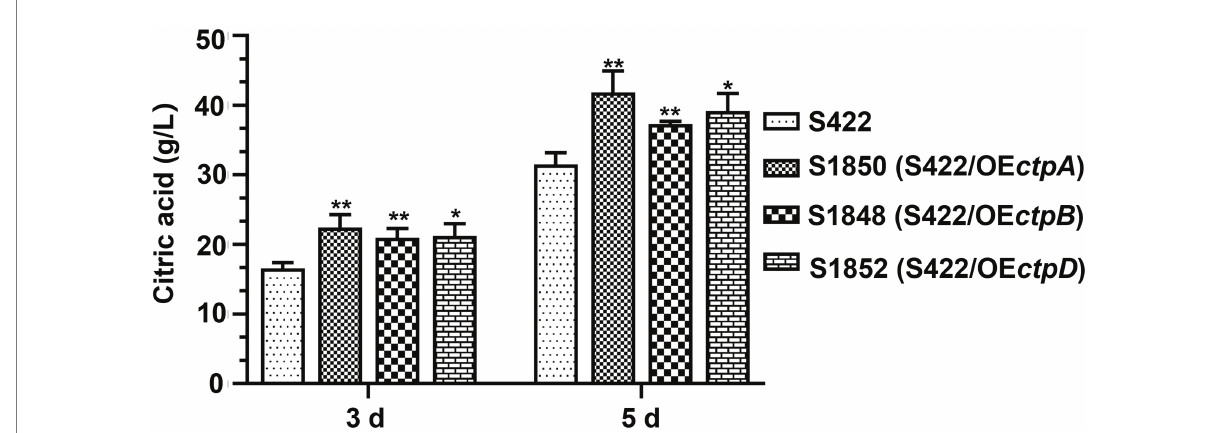
FIGURE 6 Citric acid production by A. niger S422 and S1848 (S422/OE ctpB ), S1850 (S422/OE ctpA ), and S1852 (S422/OE ctpD ). About 1 × 10 8 conidia of A. niger were inoculated in 50 ml of citric acid fermentation medium at 28 ° C for 3 and 5 days, respectively. Citric acid titers were determined by HPLC. * p < 0.05, ** p < 0.001, and **** p < 0.0001 were considered statistically significant. This meaning are described in “Statistical analyses”